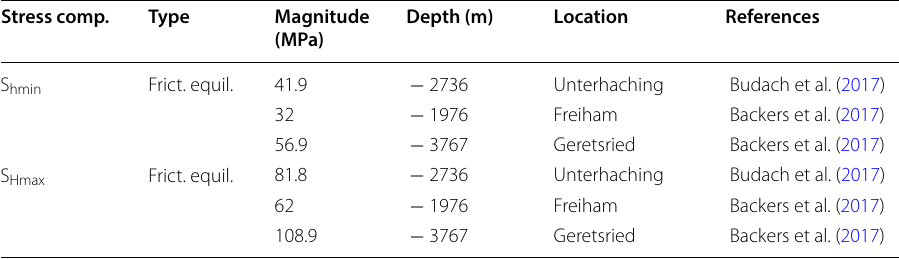
Table 3 Disclosed stress magnitude data from the model area for a transtensional stress regime. These data records are only used for comparison Stress comp. Type Magnitude Depth (m) (MPa)